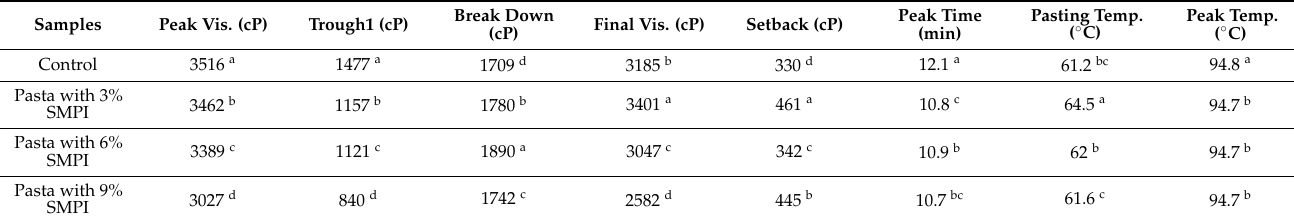
Table 3. Effect of mixing SMPI with wheat flour on RVA